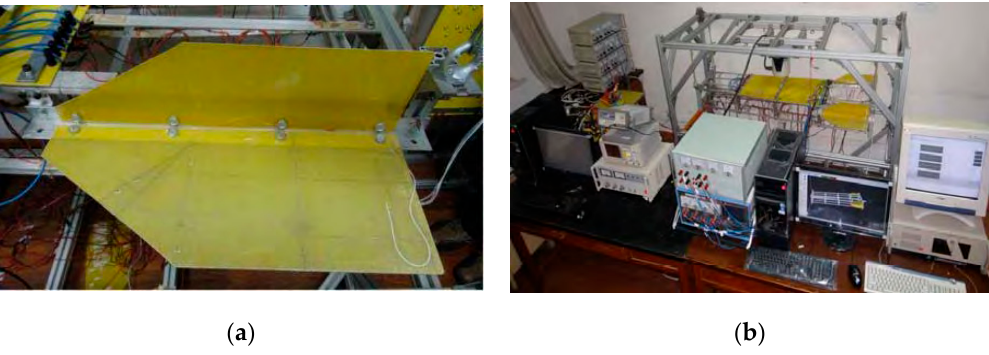
Figure 23. ( a ) Experimental model; ( b ) The whole experimental setup [87].